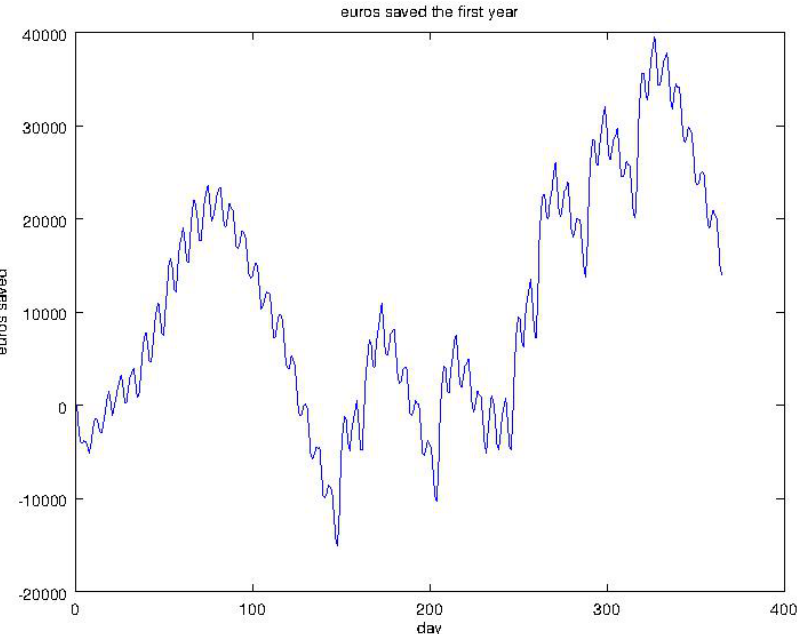
Figure 12. Operation cost saved during the first year: ammonium-based PI control vs. RL agent.